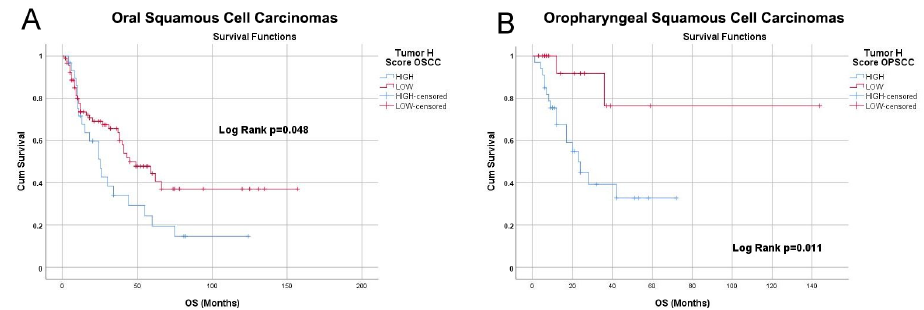
Figure 7. Kaplan–Meier Survival Curves analysis. ( A ) HIGH and LOW NRP-1 expression survival curves were compared in OSCC samples ( p = 0.048 at Log Rank test for significance). ( B ) HIGH and LOW NRP-1 expression survival curves were compared in OPSCC samples ( p = 0.011 at Log Rank test for significance).